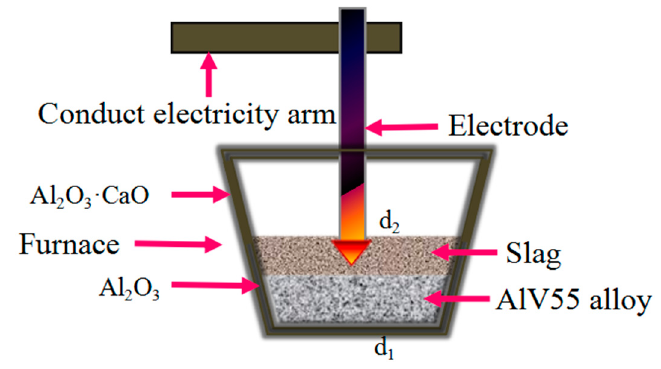
Figure 6. Assemblage used in the electrode heating process.